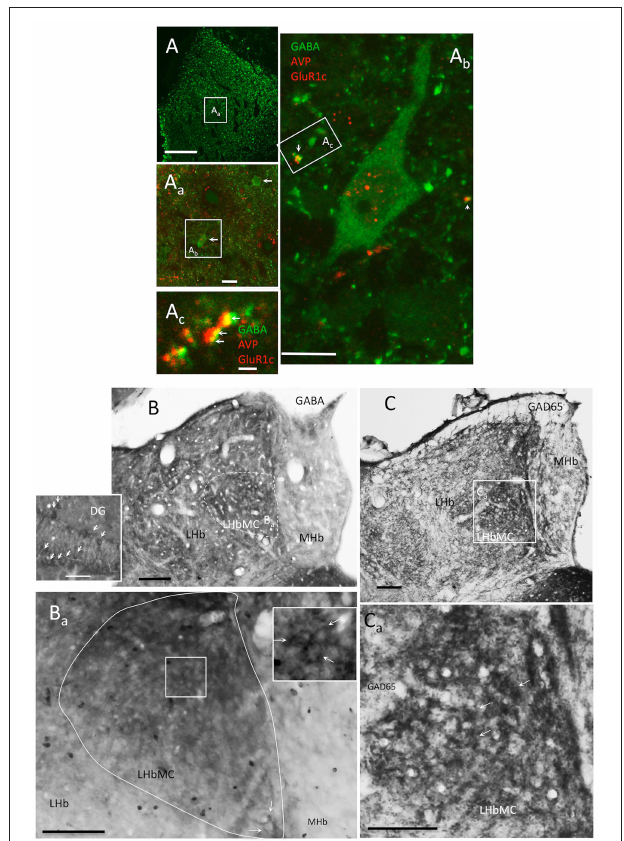
FIGURE 6 | LHbMC host a distinct population of GABAergic neurons. (A, A a ) Confocal images showing the location of some GABA + neurons (arrows) in combination with AVP and GluR1c immunofluorescence reaction, using high glutaraldehyde fixation. (A b ) An enlargement of one GABA positive neuron and its relation with the other two antigens. Notice that the antibody for GluR1c produced some nuclear background labeling. (A c ) Confocal image of 700nm thickness of a dendritic segment of the cell (A b ) . Notice that some labeled dendrites (green process) contained postsynaptic glutamate receptor type 1 (GluR1c, yellow points indicated by arrows) in juxtaposition to the AVP axon terminals (red process). (B,C) GABAergic neurons were mainly observed in lateral habenula medial central subnucleus (LHbMC) through immunoreaction against GABA and GAD65, respectively, in brain tissues posterior to 6h of intra-habenular colchicine injection which enhanced GABA and GAD65 labeling (Ribak et al., 1978). The inset is for reference immunohistochemistry reaction of dentate gyrus (DG) of the same brain section. Notice the similarities of labeling patterns between DG GABAergic neurons (arrows in inset of B ) and the habenular-labeling pattern (indicated by arrows in the inset of B a ). (C) Immunoreaction on the same brain tissue, using antibody against GAD65. (C a ) Magnification centered at the medio-central subnucleus of the lateral habenular complex, some labeled cells are indicated with white arrows. Scale bars: A : 100 µ m; A a : 20 µ m; A b : 10 µ m; A c : 1 µ m; rest: 50 µ